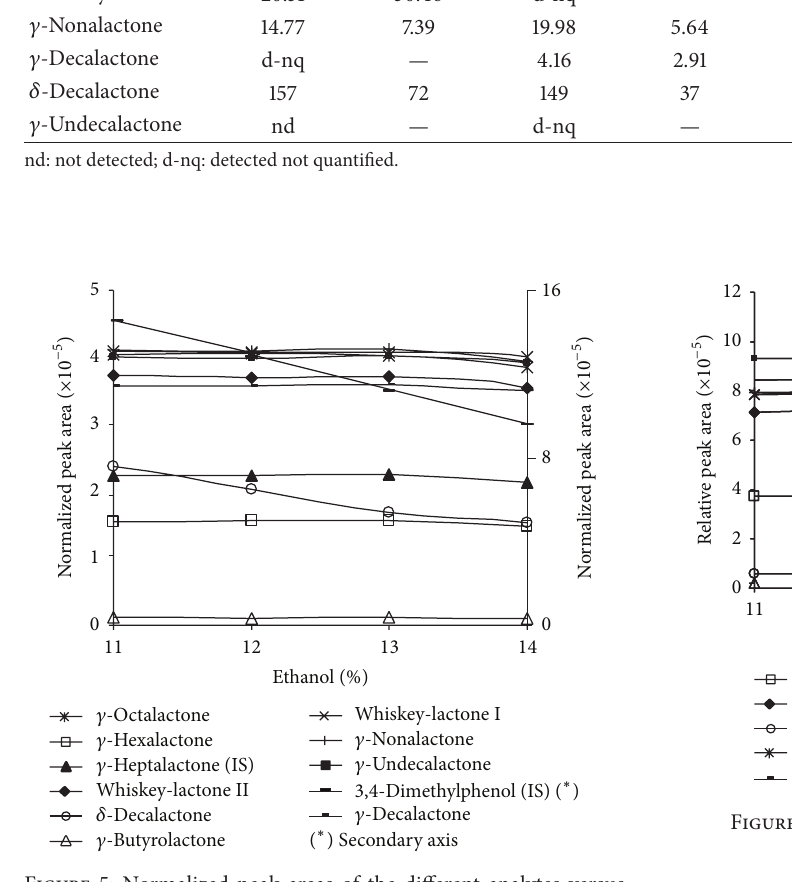
Figure 5: Normalized peak areas of the different analytes versus alcoholic degree on a PA fiber.